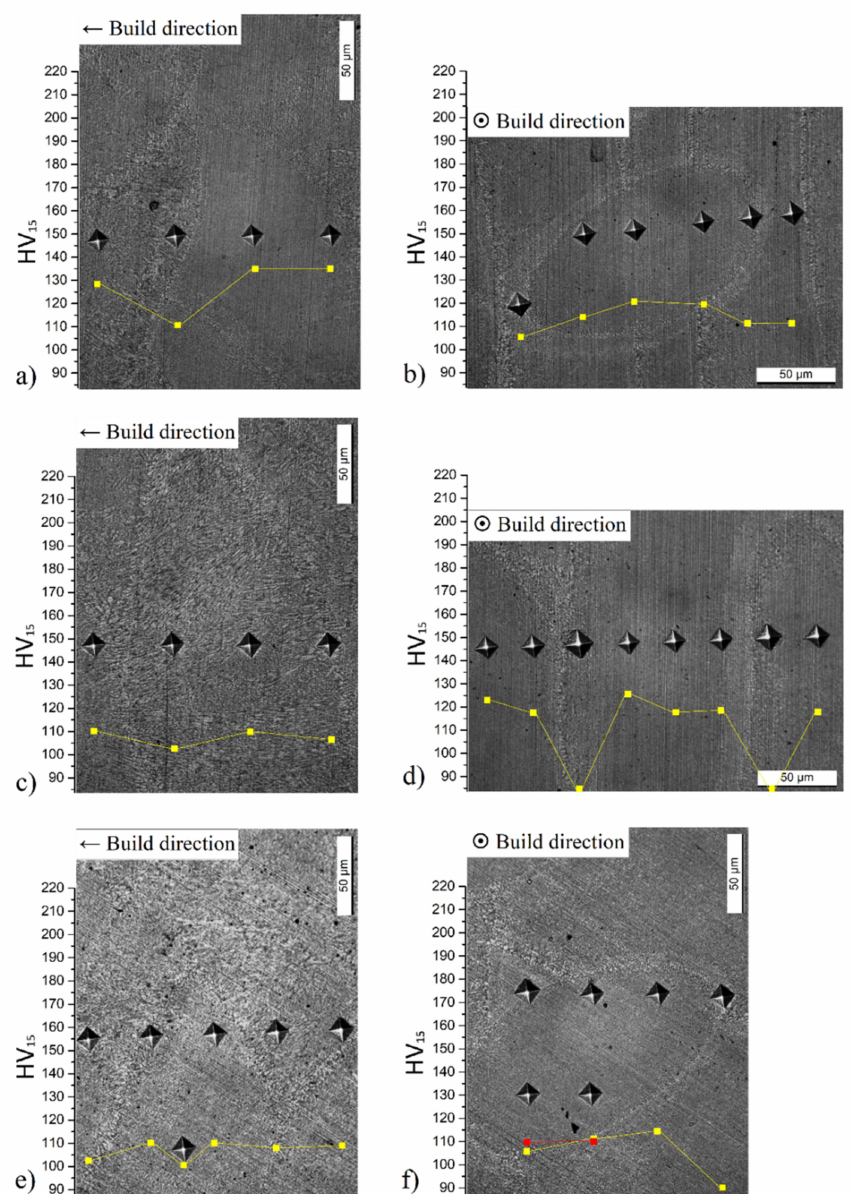
Figure 3. Vickers microhardness profiles (yellow and red curves) of as-built AlSi10Mg 90-samples ( a – d ) and 50-samples ( e , f ) performed in XZ ( a , c , e ) plane and XY plane ( b , d , f